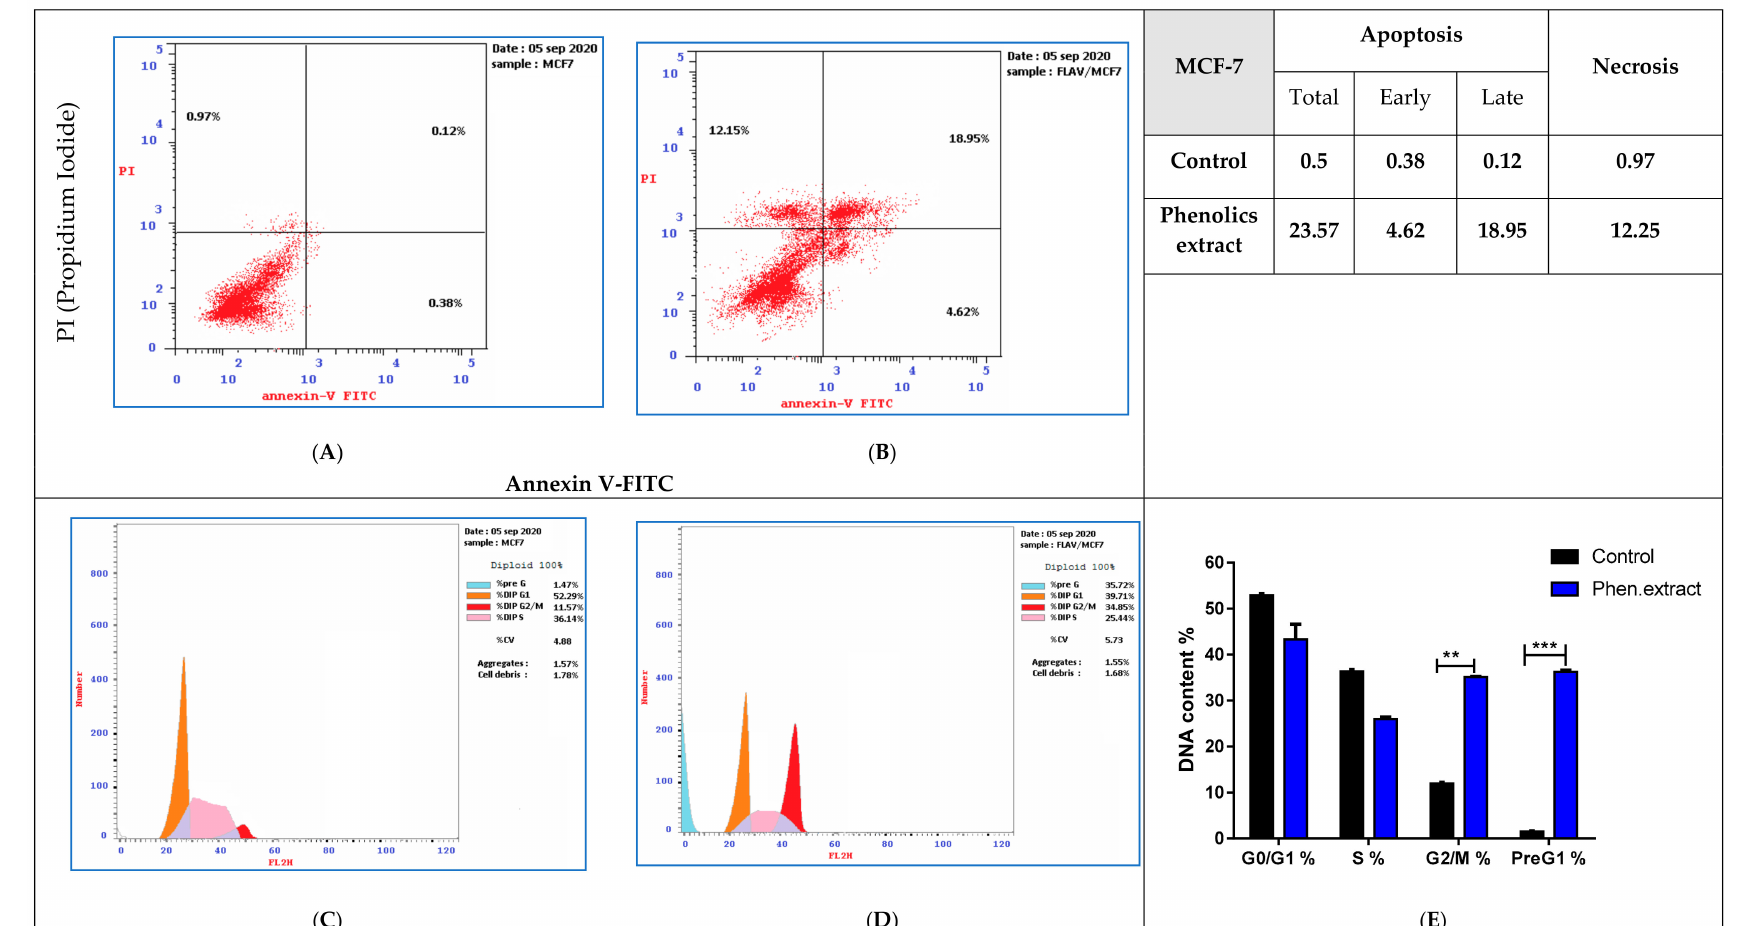
Figure 6. FITC / Annexin-V-FITC / PI di ff erential apoptosis / necrosis ( A ) untreated control, ( B ) Phenolics extract (IC 50 = 13.04 µ g / mL, 48 h) and DNA content-flow cytometry aided cell cycle analyses ( C ) untreated control, ( D ) Flavonoid extract (IC 50 = 13.04 µ g / mL, 48 h), ( E ) bar chart representation) in MCF–7. ** p ≤ 0.05 and *** p ≤ 0.001 are significant di ff